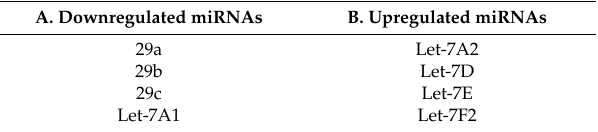
Table 1. MicroRNAs (miRNAs) down- or upregulated in the bortezomib-, carfilzomib-, and ixazomib-resistant cells compared to parental RPMI8226 cells. ( A ) Individual miRNAs that were downregulated at least 10-fold in all three of the proteasome inhibitor (PI)-resistant RPMI8226 cell lines compared to parental RPMI8226 cells. ( B ) Individual miRNAs that were upregulated at least 10-fold in all three of the PI-resistant RPMI8226 cell lines compared to parental RPMI8226 cells.